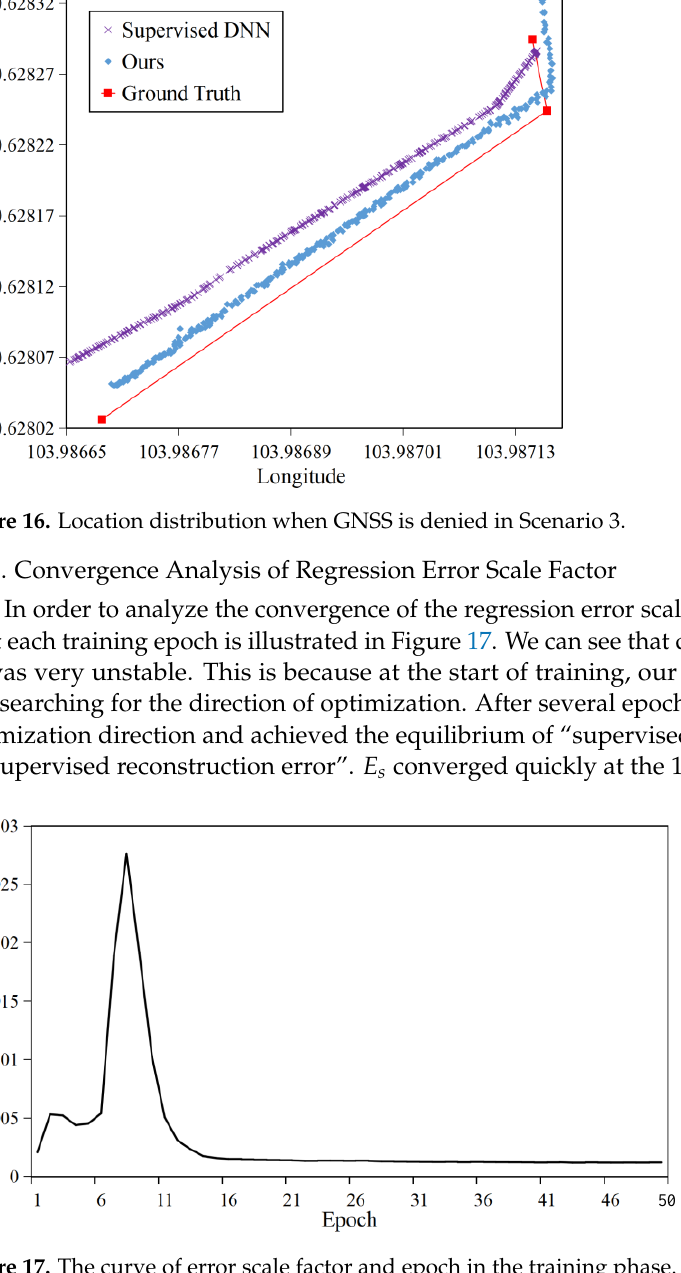
Figure 17. The curve of error scale factor and epoch in the training